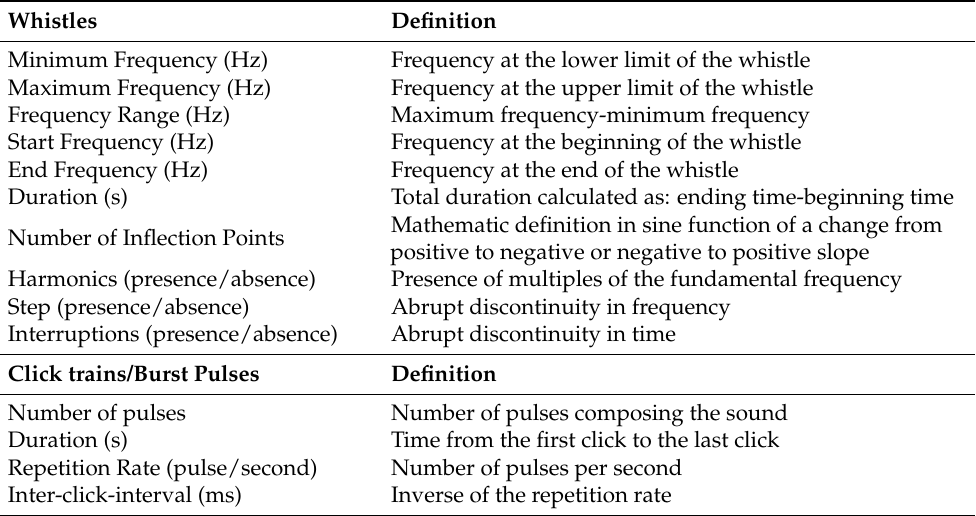
Table 2. Acoustic parameters extracted for good and high-quality whistles, click trains, and burst pulses.